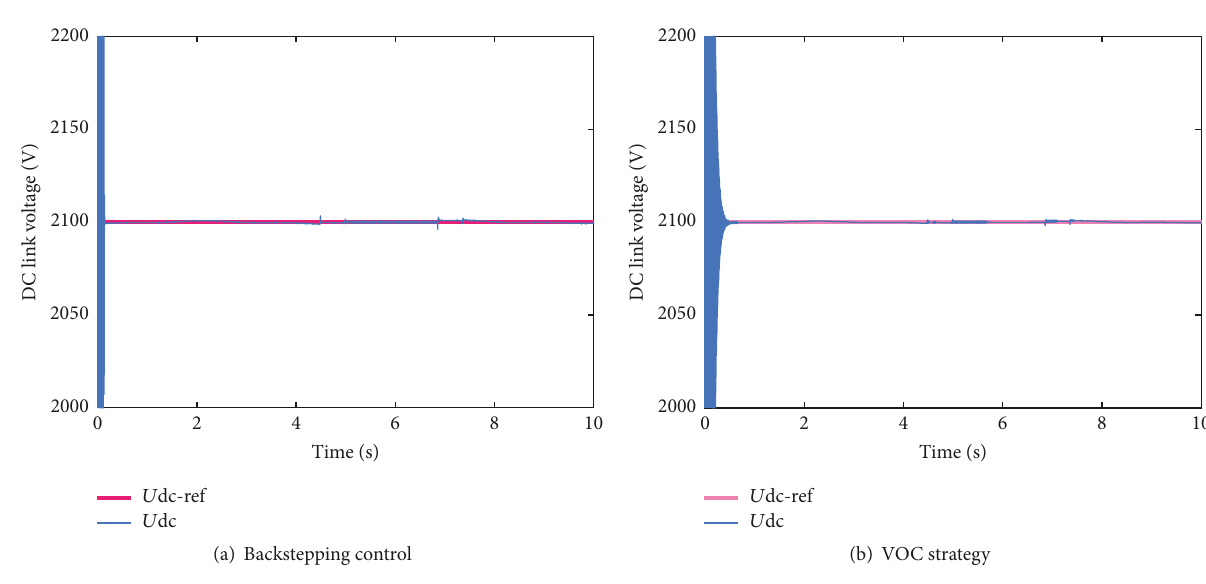
Figure 19: dc - link voltage